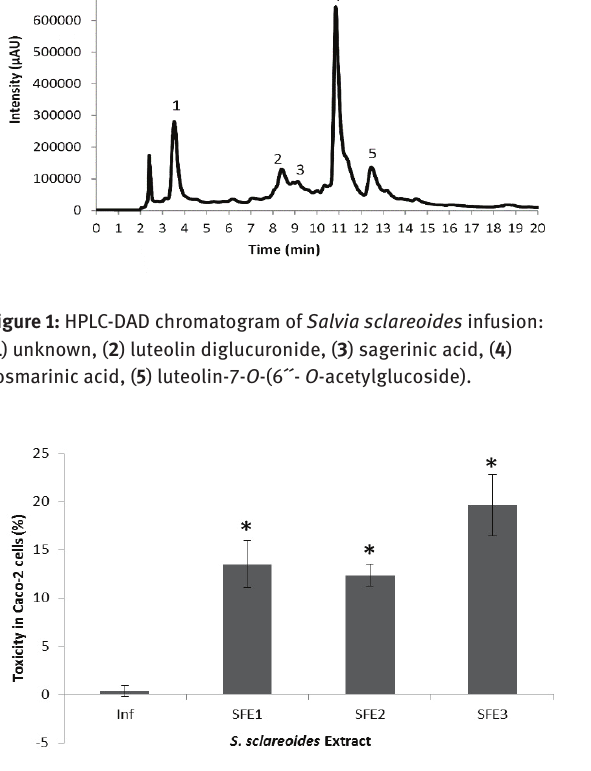
Figure 2: Toxicity of the infusion (Inf.) and of the first three fractions (SFE1-3) of the supercritical fluid extract from Salvia sclareoides for Caco-2 cells, presented as % of decrease in cell viability. * Values statistically different from the control ( P < Table 2: Putative identification of compounds present in Salvia sclareoides infusion by LC-MS.